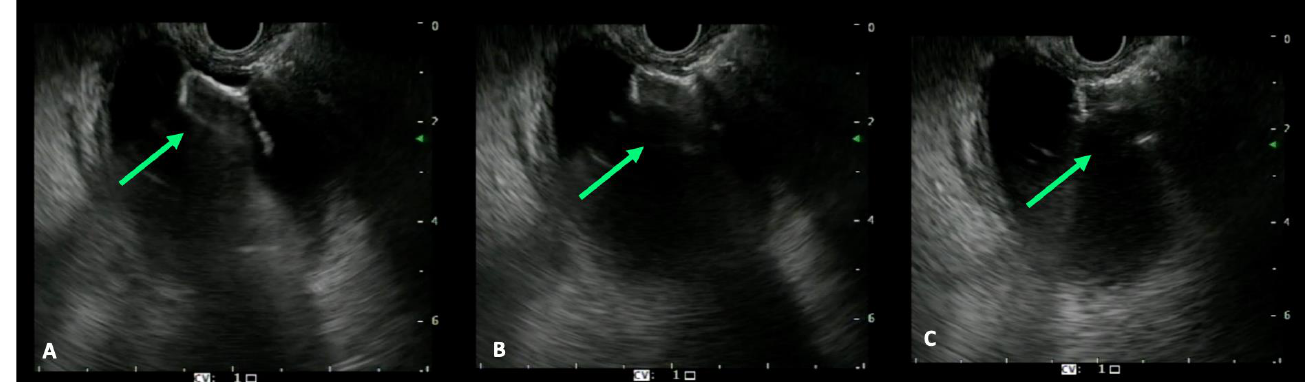
Figure 3. EUS view of the correct positioning of the LAMS: ( A ) completely open distal flange in the shape of a “ frisbee ” ; ( B ) the distal flange is pulled back towards the intestinal wall; ( C ) distal flange of oval shape.